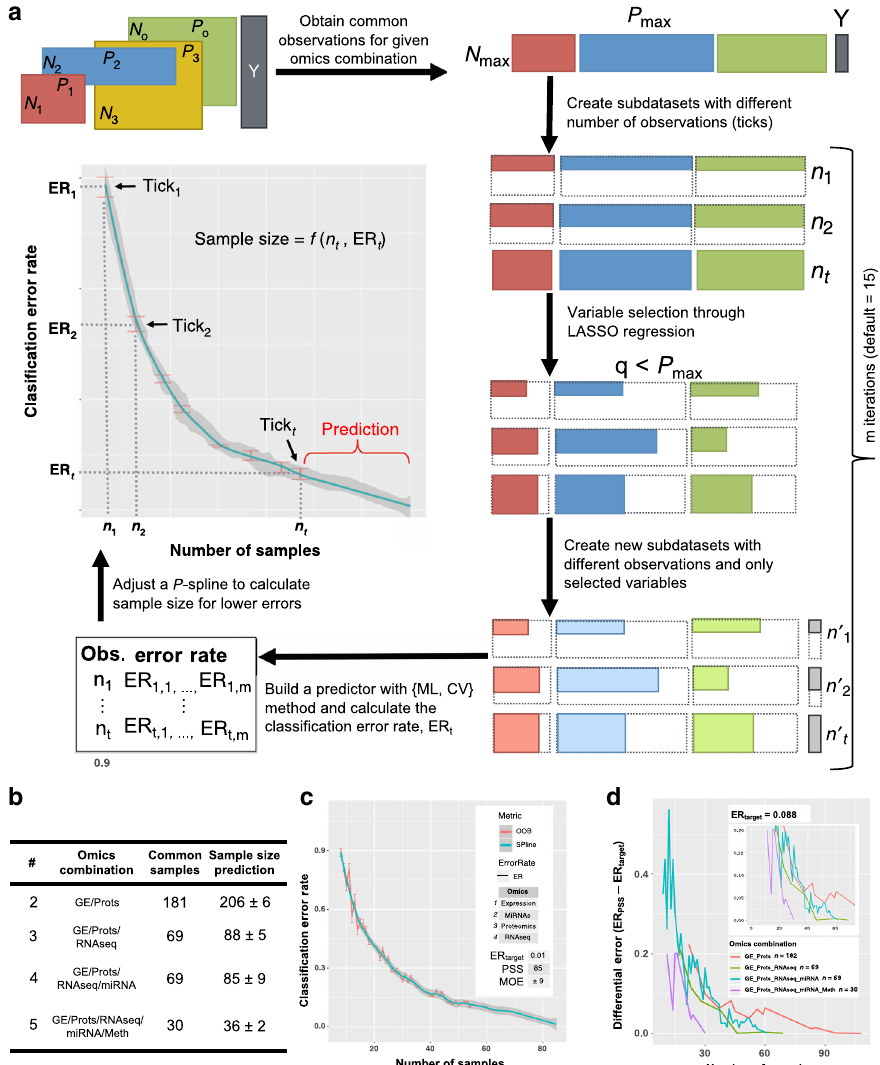
Fig. 5 The MultiML algorithm. a Given a multi-omic dataset with O different omic types and N O samples per omic and a classi fi cation vector Y, MultiML obtains the maximum number of common observations N max ( N max ≤ N O ) for the combination of omic types speci fi ed by the user. MultiML then creates subdatasets (ticks) having different number of observations ( n t ) from the available N max and obtains the variables that best explain each tick through LASSO regression. Taking provided machine learning algorithm ML and cross-validation method CV, the selected variables at each tick are used to predict the classi fi cation error rate (ER) on a different random subdatasets of size n t , resulting in ER t . This variable selection-ER prediction process is repeated through m iterations to obtain an average ER and con fi dence interval for each tick. On these, n 1 to n t and ER 1 to ER t values, a fi rst-order-smoothed penalized P-spline regression is adjusted to estimate the learning curve that will allow the prediction of classi fi cation ERs for sample sizes larger than N max . b – d MultiML results on the TCGA Glioblastoma data. b Predicted sample size for different omics combinations using a target ER of 0.01. Margin of error is given as number of samples. GE expression microarrays, Prots proteomics, miRNA-seq microRNA microarrays, Meth methylation microarrays. c Example of MultiML graphical output with the predictive P-spline for a combination of four omics types. OOB out-of-bag classi fi cation ER, ER target target error rate, PSS predicted sample size, MOE margin of error. d MultiML evaluation. An increasing number of observations and omic types were run as input data in MultiML having as ER target , the ER achieved with complete data for four omics (69 observations). For the PSS, their ER are recovered from the actual data and their deviation from ER target is calculated as Δ Error. The Δ Error is plotted against the size of the input data. Accuracy in ER predictions increases with the size of input data and the number of fl exible framework that (i) predicts sample sizes using different combinations of omics platforms to obtain the best predictive set, as omics technologies may have similar or complementary information content for a given classi fi cation scenario; (ii) accepts user-provided machine learning algorithms beyond the imple- mented partial least squares discriminant analysis (PLS-DA) and random forest (RF) methods; and (iii) offers job parallelization options to speed up calculations when high-performance com- puting resources are available.